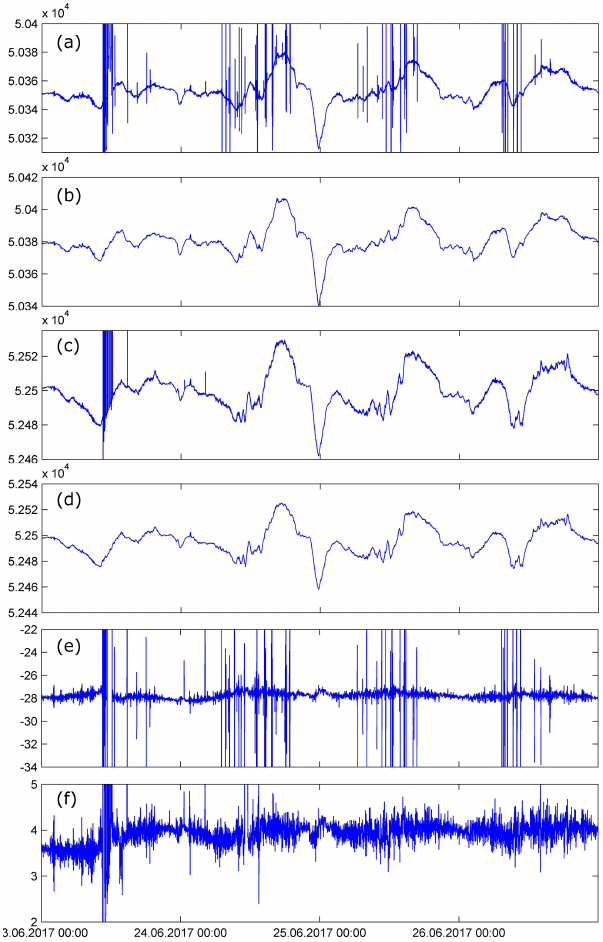
Figure 8. Comparison between the data from POS-4 and the obser- vatory magnetometers: comparison of the Z data between POS-4 (a) and FGE (b) magnetometers; comparison of the total field F data between POS-4 (c) and GSM-19 (d) magnetometers; differ- ences between the Z (e) and F (f) records.